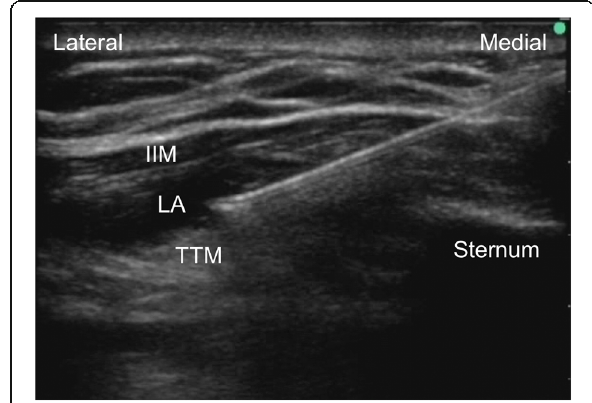
Fig. 2 Ultrasound image of transversus thoracic muscle plane block. Local anesthetics were spread between the internal intercostal muscle and the transversus thoracic muscle. IIM, internal intercostal muscle; LA, local anesthetics; TTM, transversus thoracic